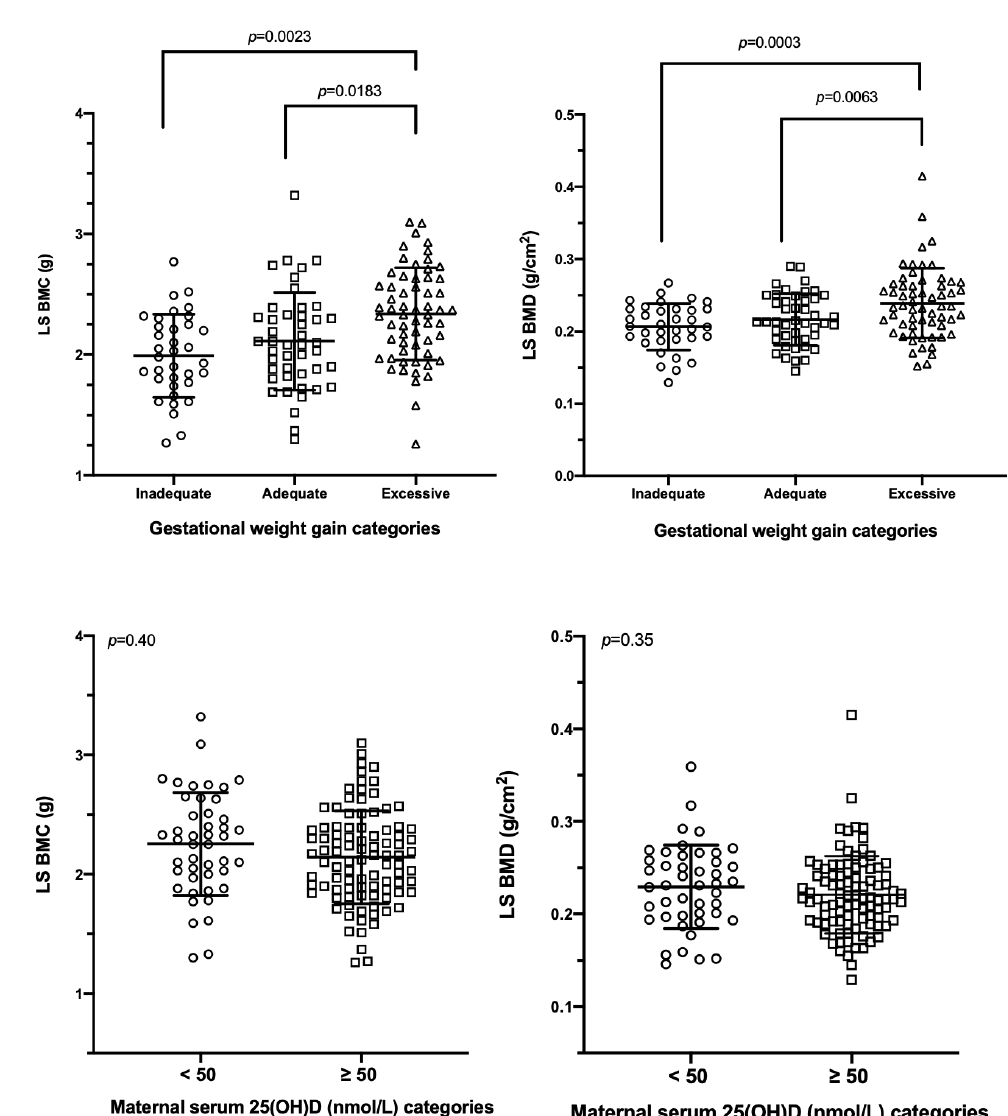
Figure 4. Lumbar spine bone mass in the neonatal period according to gestational weight gain categories and maternal 25(OH)D status. Data are reported as mean ± SD and were analyzed using mixed linear model accounting for the fixed effects of the infant’s sex, age, and LAZ score and the mother’s 25(OH)D categories, pre-pregnancy BMI categories, gestational weight gain categories, education, self-reported population group, as well as family income ( p < 0.05, post hoc adjustment). Abbreviations: 25(OH)D: 25-hydroxyvitamin D, LS BMC: lumbar spine bone mineral content, and LS BMD: lumbar spine bone mineral